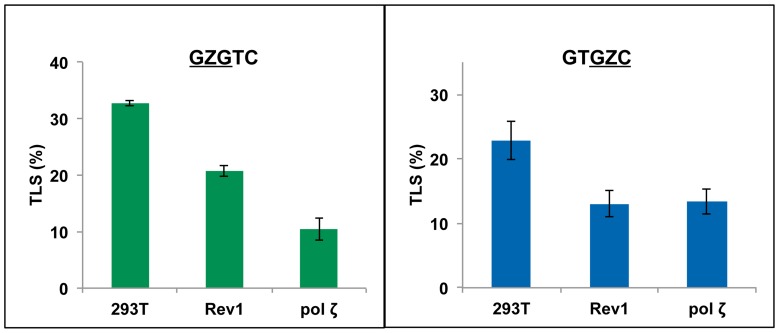
Effects of siRNA knockdowns of pol ζ and Rev1 on the extent of replicative bypass of Z for
GZGTC and GTGZC
 constructs.Percent TLS in the pol knockdowns was measured using an internal control of unmodified plasmid containing a different sequence near the lesion site. When control siRNA was used, the % bypass remained the same as in HEK 293T cells.